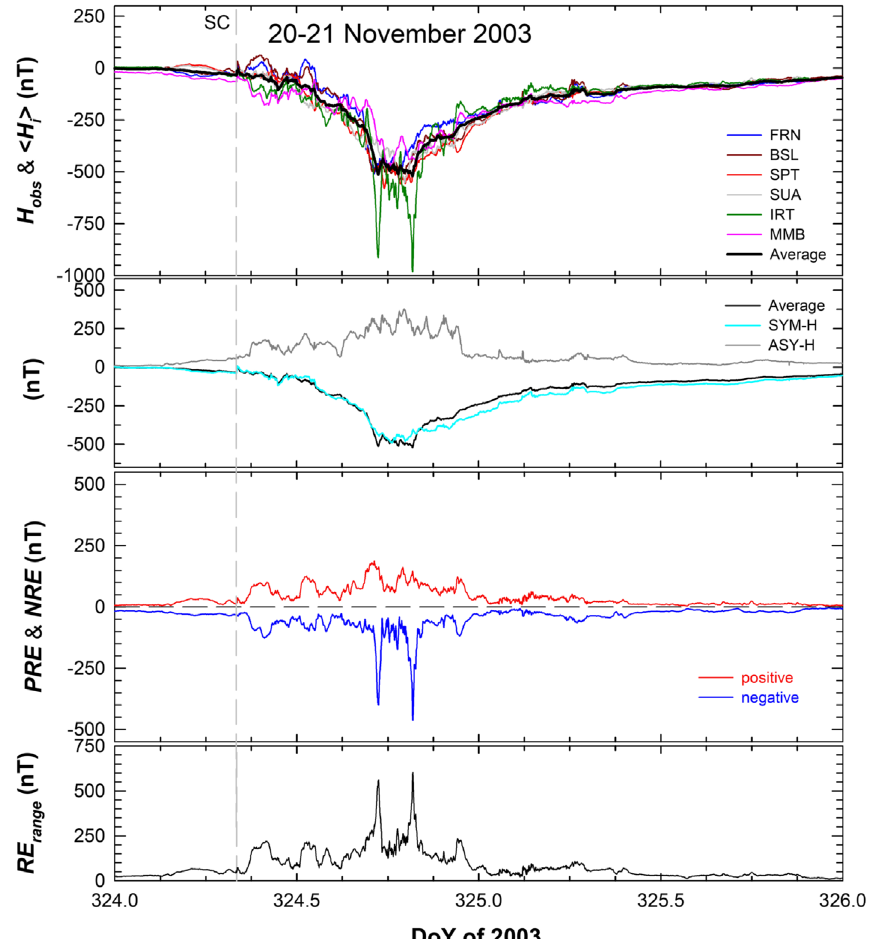
Fig. C.6. The event on 20 November 2003 (event